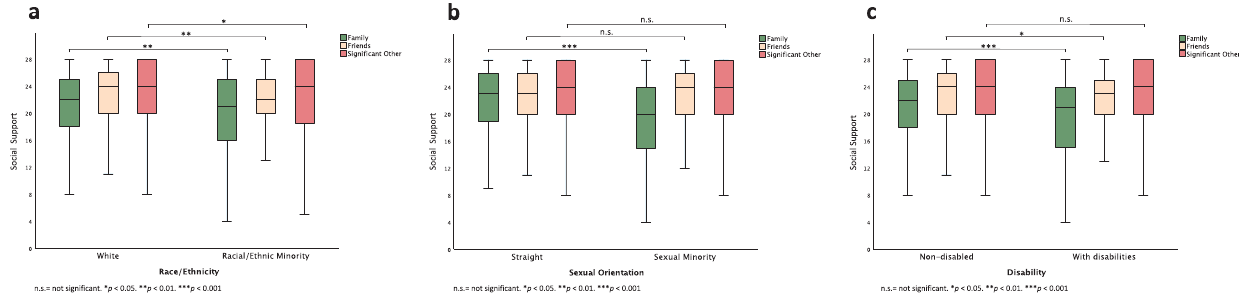
Fig. 1 Levels of social support from family, friends, and signi fi cant other across demographic groups during the COVID-19 pandemic, 2020 – 2021. Differences in social support between a White individuals and racial/ethnic minorities; b straight individuals and sexual minorities; c non-disabled individuals and persons with disabilities. (n.s. = not signi fi cant. * p < 0.05; ** p < 0.01; *** p < 0.001.).